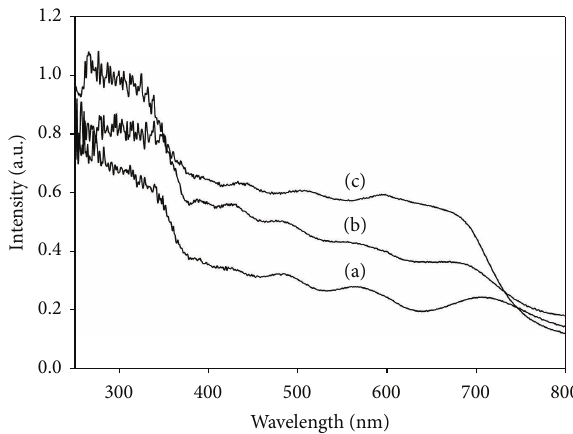
Figure 5: The adsorption capacity of different absorbents towards PFOA in aqueous